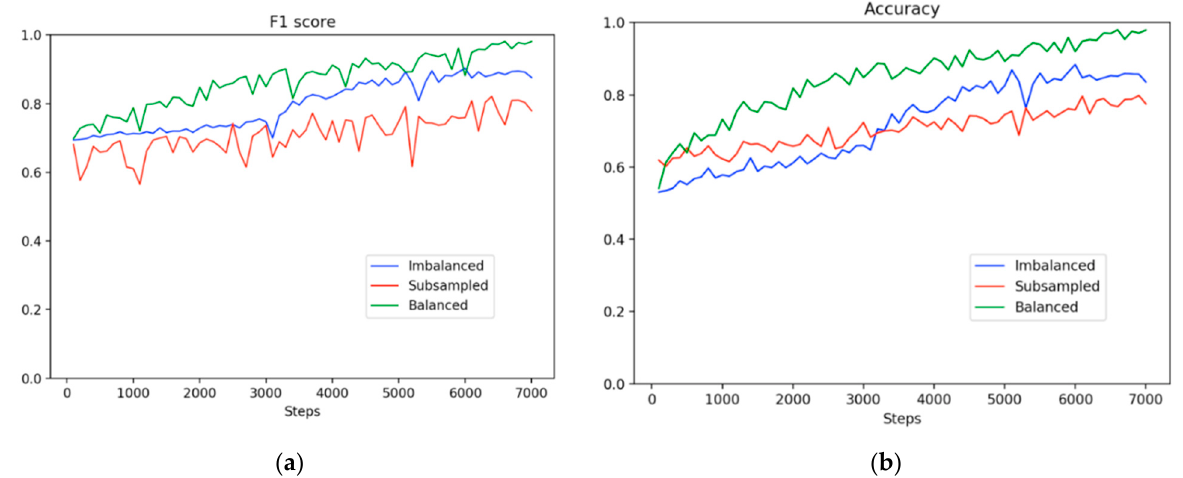
Figure 5. Comparison of the learning trajectories. ( a ) F1 score and ( b ) accuracy.